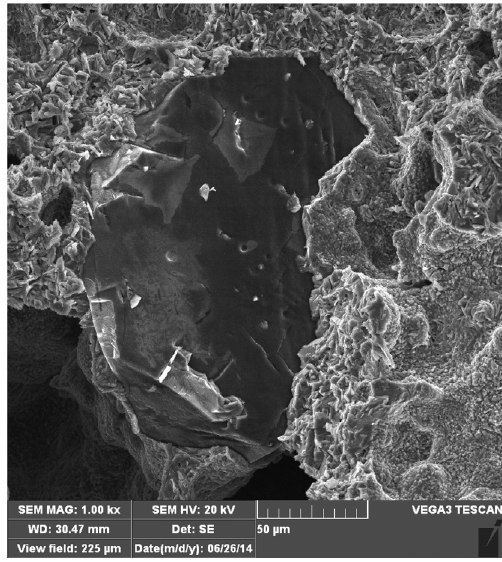
Figure 7: Fracture micrograph of the synthesized sample containing 170/200 mesh